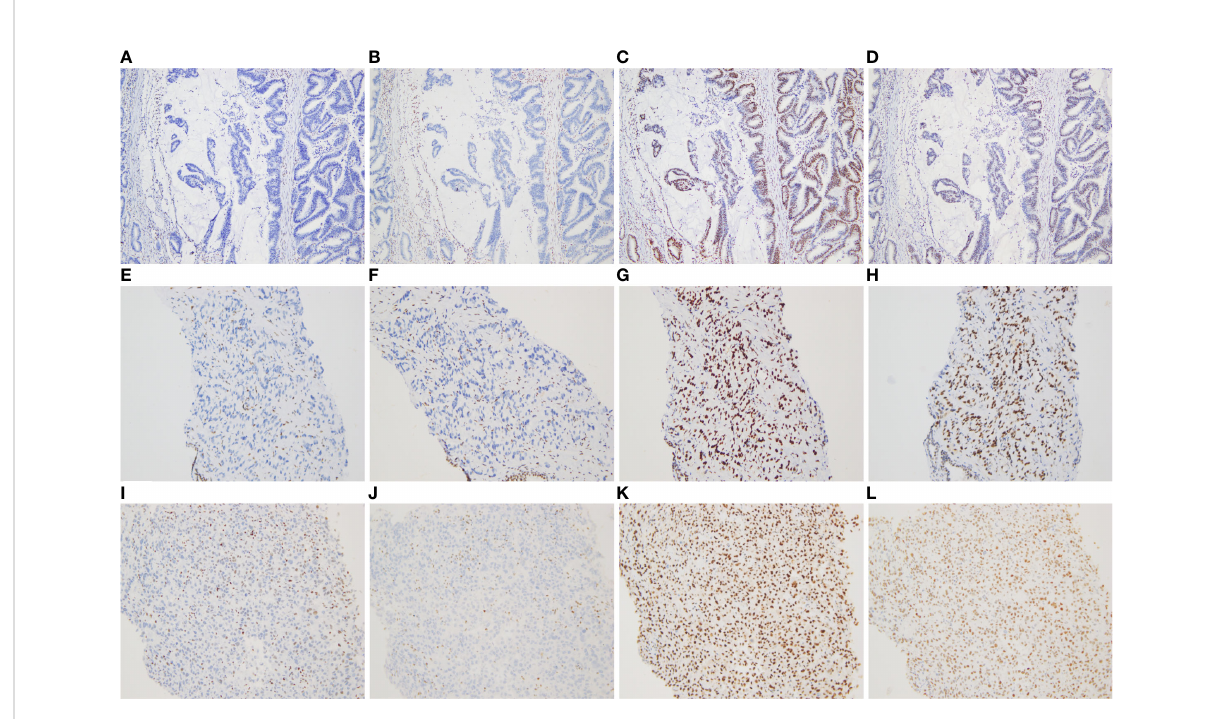
FIGURE 2 Immunohistochemical staining for DNA mismatch repair proteins (MMR proteins MSH6, MSH2, MLH1, and PMS2) of three tumors (×100). (A – D) Absence of MSH6 and MSH2 staining, and positive staining for MLH1 and PMS2 in the rectal mucinous adenocarcinoma; (E – H) Absence of MSH6 and MSH2 staining, and positive staining for MLH1 and PMS2 in the prostate adenocarcinoma; (I – L) Absence of MSH6 and MSH2 staining, and positive staining for MLH1 and PMS2 in the undifferentiated sarcoma of left